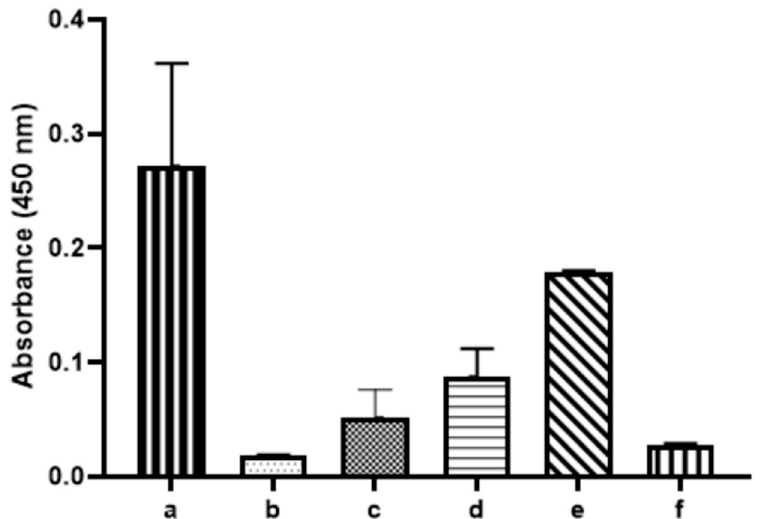
Figure 4. Competition of peptide #8 (1 µM) and F1 antibody (0.25 µg/mL) for the F1 antigen on E. coli XL1-blue/pYPR1 after incubation for 1 h at 4 °C; a. E. coli XL1-blue/pYPR1 cells incubated with F1 antibody; b. E. coli XL1-blue/pYPR1 alone; c. parent cells E. coli XL1-blue plus F1 antibody; d. E. coli XL1-blue/pYPR1 incubated with peptide #8 for one hour, and then the F1 antibody was added; e. E. coli XL1-blue/pYPR1 cells incubated with F1 antibody for one hour and then peptide #8 was added; f. E. coli XL1-blue cells incubated with peptide #8 and the F1 antibody. Error bars represent the mean ± SD of results from two independent experiments.